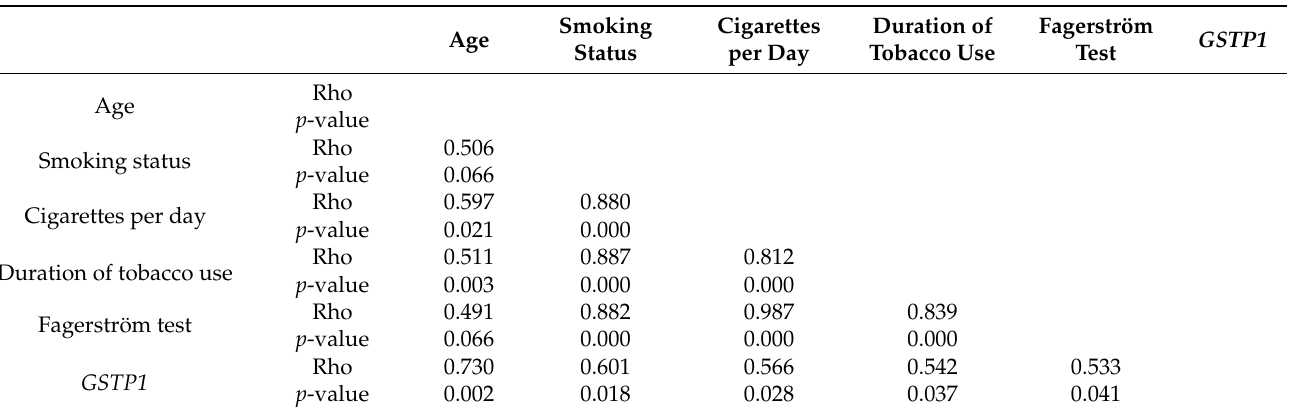
Table 5. Spearman’s correlation coefficient of the control